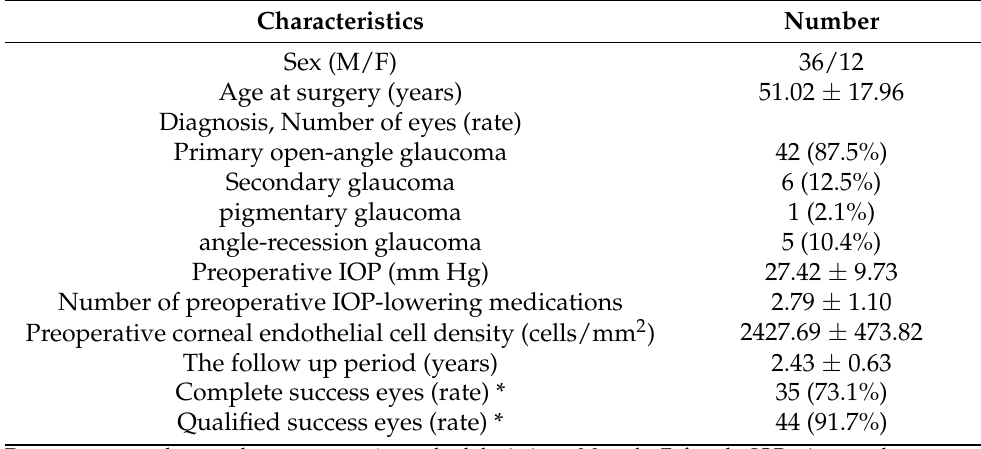
Table 1. Patients’ general information.